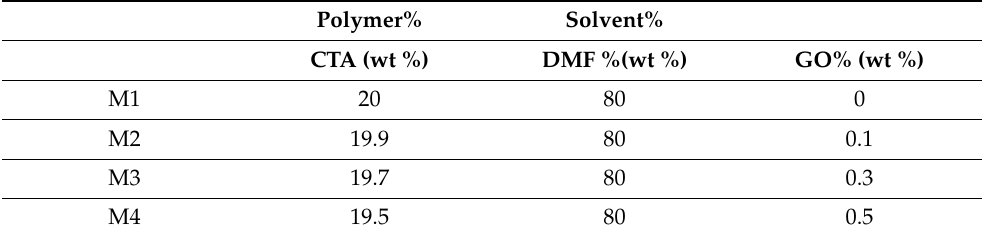
Table 1. The compositions of the casting